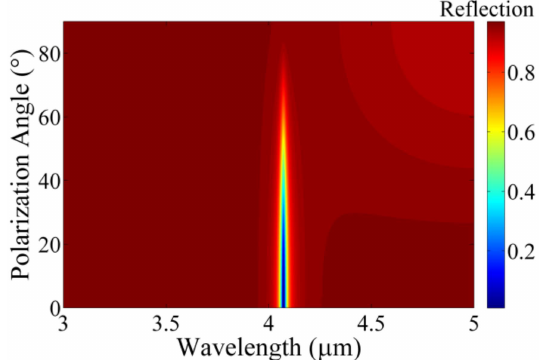
Figure 6. Transmission versus the polarization angle. Traverse-magnetic (TM) polarization corresponds to 0